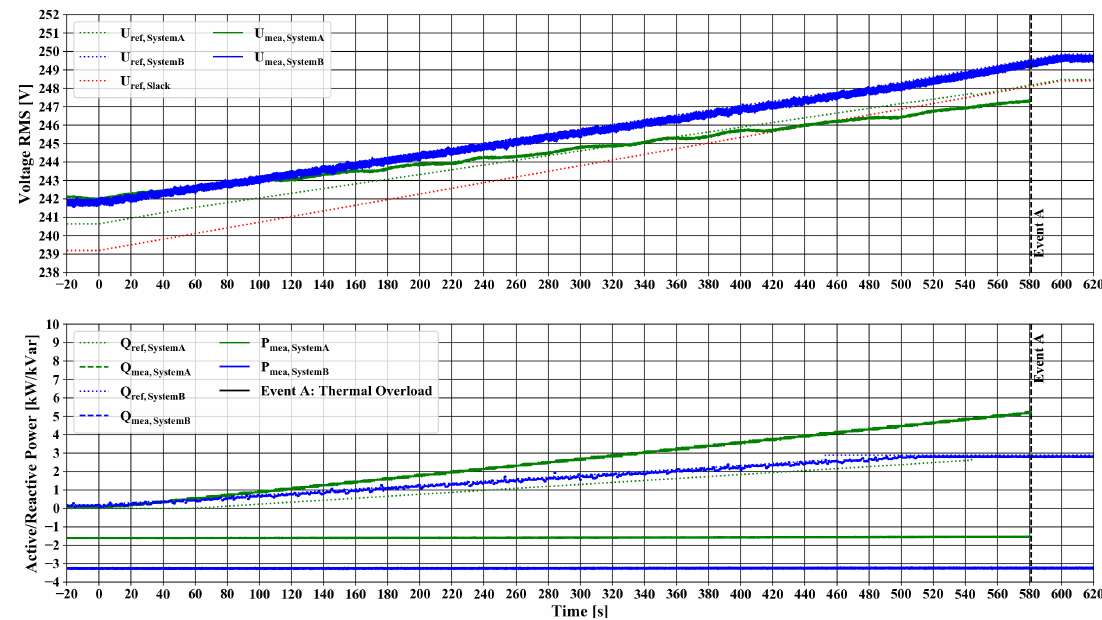
Figure 11. Comparison of the different system responses to the deviation voltage ramp with the raise from 1.04 to 1.08 p.u. at the slack node over the course of 10 min. The thermal overload of the PI of System Setup A is indicated. Table 6. Statistical key parameter for the characterisation of system response for the ramp change. Comparison of ideal simulation and system